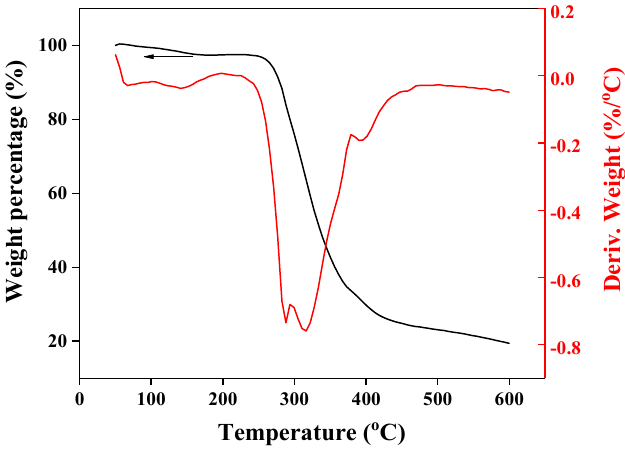
Figure 5. Thermogravimetric analysis (TGA) curve of the PBLG-PPG-PBLG film.